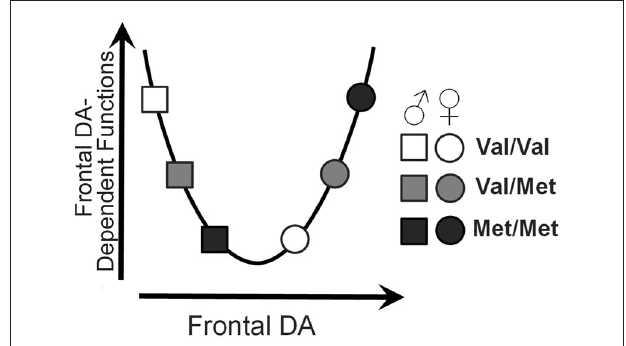
FIGURE 6 | U-shaped model of frontal dopamine function. Theoretical influences of both sex and COMT genotype on frontal dopamine levels by which sex and COMT genotype may affect frontal dopamine-dependent